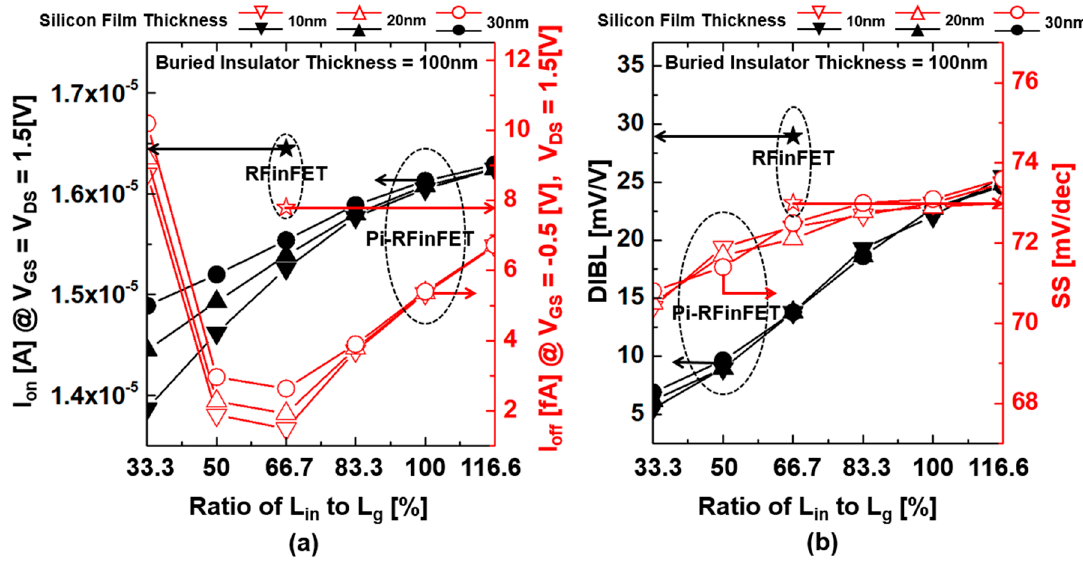
Figure 4. ( a ) I on , I off and ( b ) drain-induced barrier lowering (DIBL), subthreshold slope (SS) characteristics of Pi-RFinFET and Pi-FinFET according to the ratio of L in to L g when L g is 30 nm.